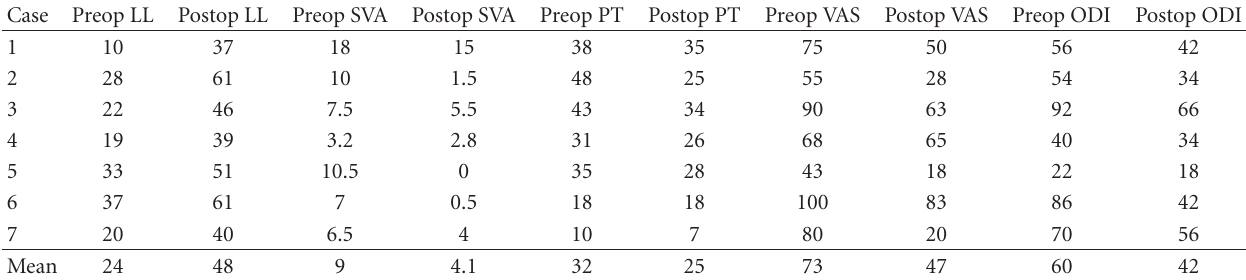
Table 2: Pre- and postoperative spinopelvic parameters and outcome measures of the